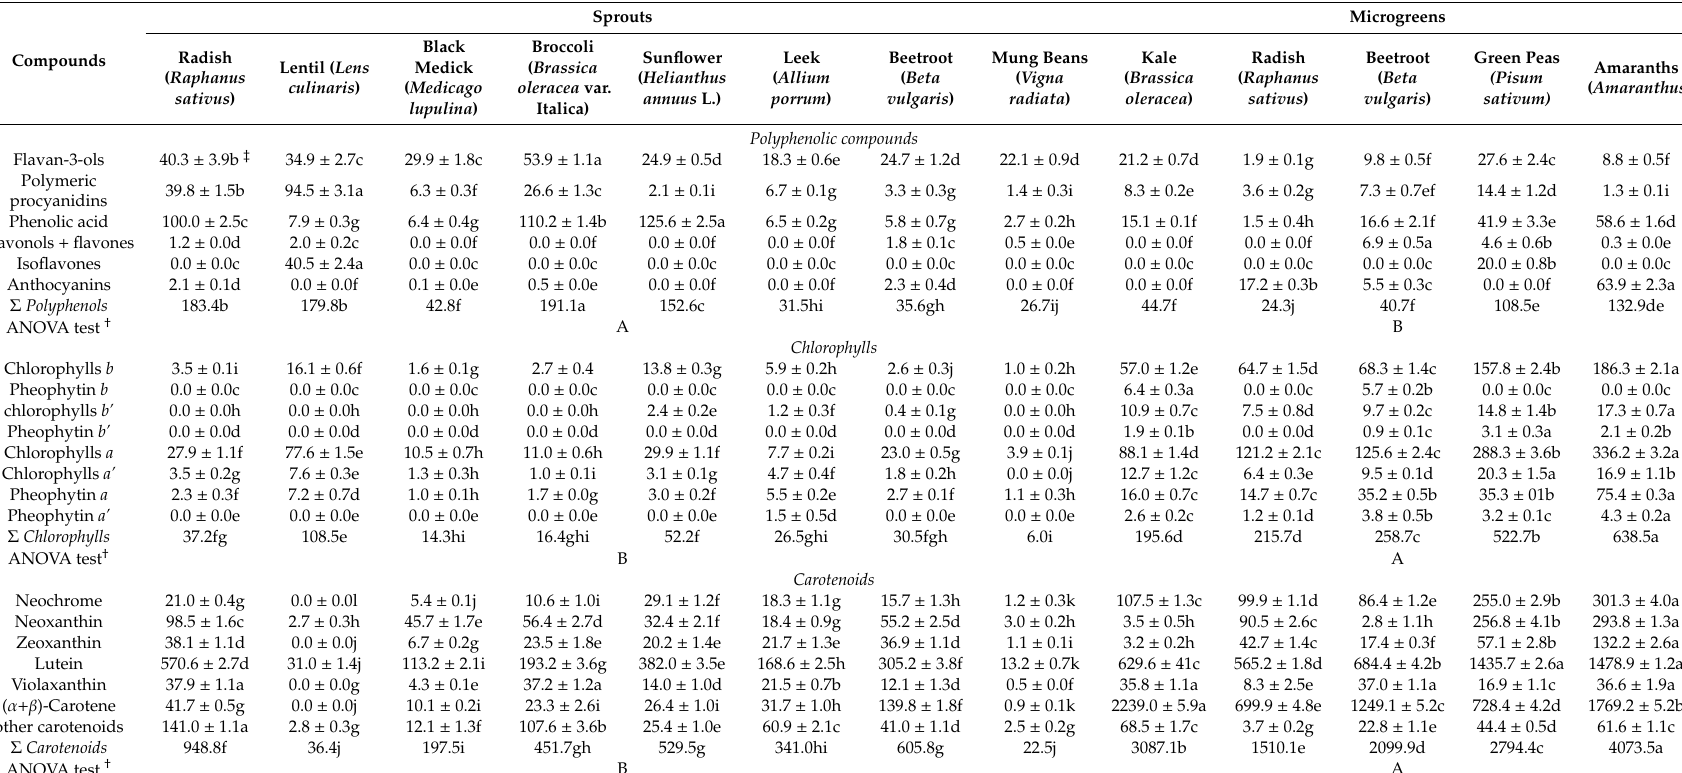
Table 2. Polyphenols [mg / 100 g fw], carotenoids and chlorophylls [ µ g / g fw] of sprouts and